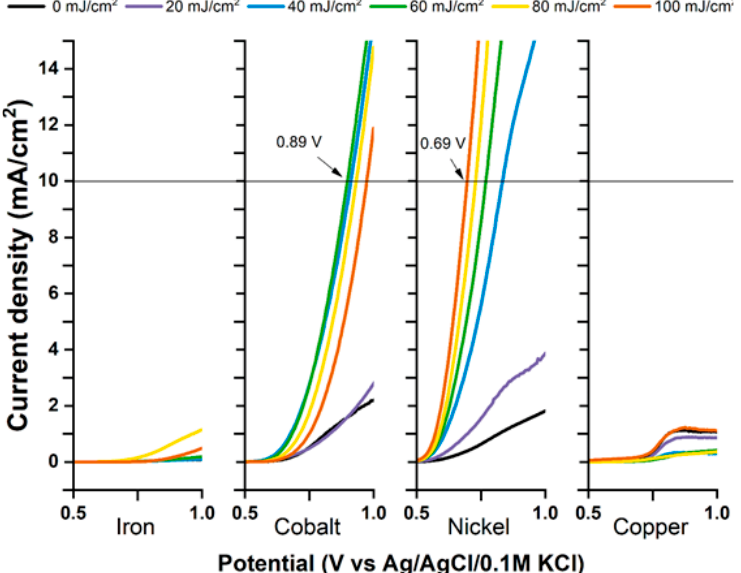
Figure 13. Potentials of oxygen evolution reaction for metal-modified and laser-treated samples. Unmodified TNTs are inactive toward OER within the measured range. Reprinted with permission from [63].